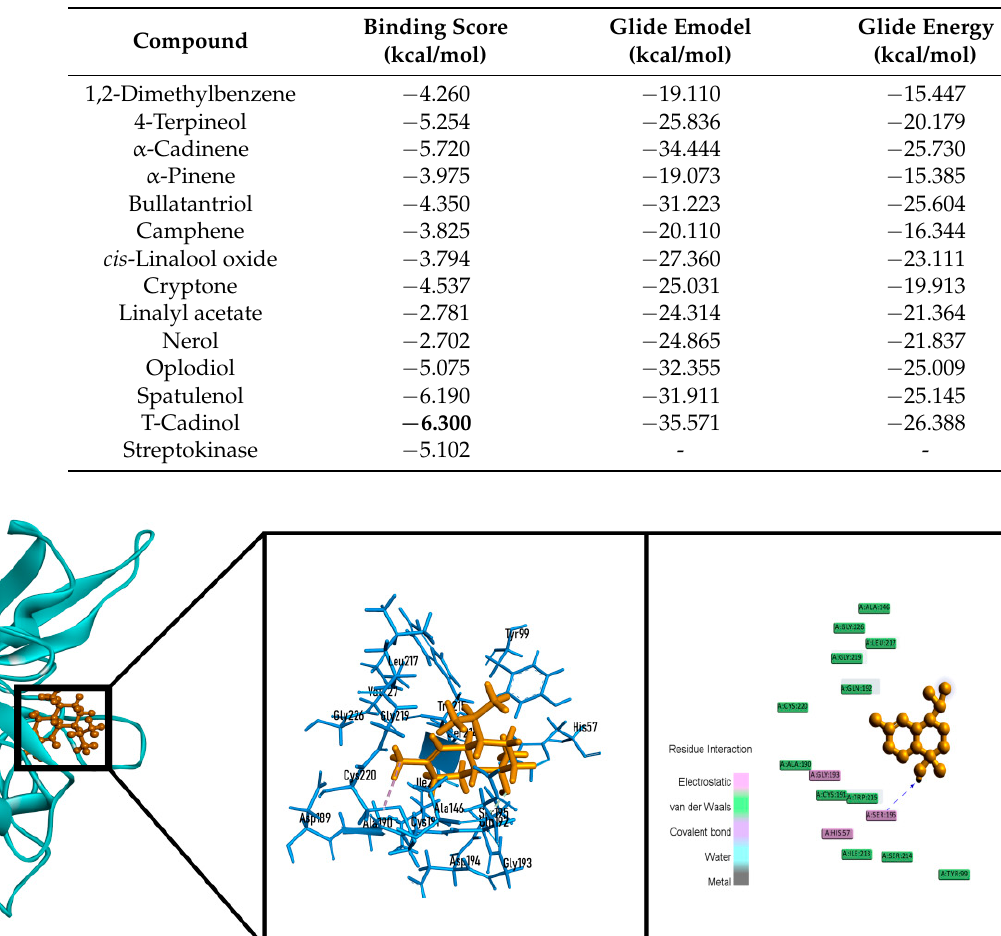
Table 3. Docking score of the phytochemical compounds of essential oil in leaves of H. aromatica against tissue plasminogen activator receptor (PDB: 1A5H) for thrombolytic activity (Bold indicates lower docking score).